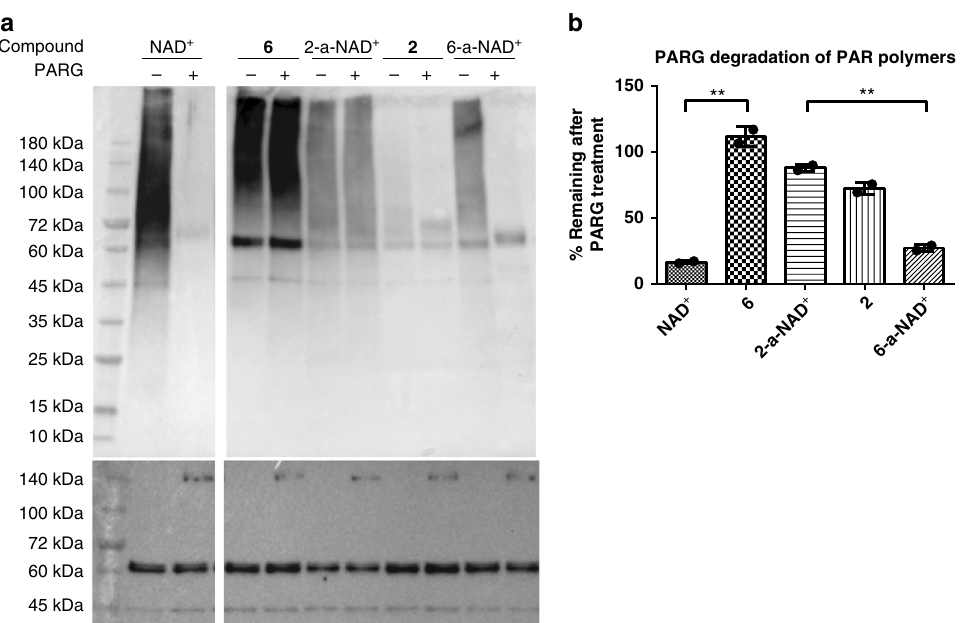
Fig. 6 PARG-mediated degradation of PAR polymers. a Immunoblot analysis of auto-modi fi ed PARP1 without and with the addition of human PARG as detected by the Fc-WWE antibody for NAD + -based PAR polymers and the streptavidin-HRP conjugate for NAD + analogues-derived PAR polymers. PARP1 and PARG loading controls were detected by the anti-His 6 antibody. b The percentage of remaining PAR polymers post-PARG treatment for auto-modi fi ed PARP1 by NAD + and NAD + analogues on the basis of densitometric analysis of the PARP1 automodi fi cation without and with the addition of human PARG. ** P < 0.01 by one-tailed unpaired t -test. Error bars represent standard deviation of two replicates. Source data are provided as a Source Data fi